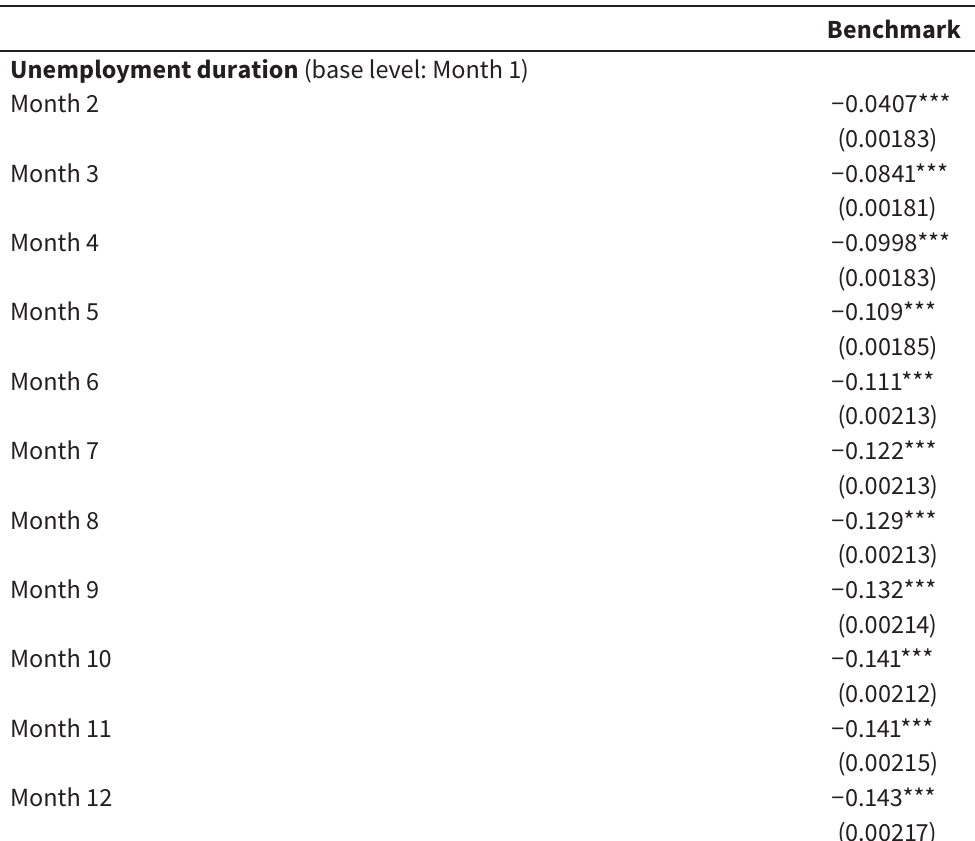
The impact of abolition of the hiring subsidy on the job-finding rate: full results of the benchmark specification